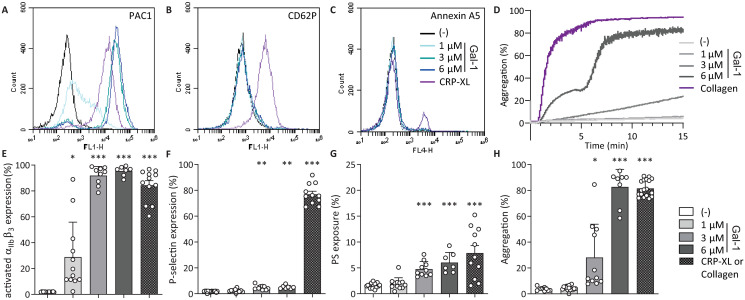
Galectin-1 induces different platelet responses.Flow cytometry measurements of platelets, assessing activation of integrin αIIbβ3 and P-selectin using fluorescently labelled PAC-1 (A, E), anti-CD62-P (B, F), and annexin A5 (C, G), respectively. Representative histograms represent washed platelets incubated with different concentrations of gal-1 (A-C) or 1 μg/mL CRP-XL for 15 minutes and bar graphs represent the percentage of platelet αIIbβ3 activation (E), P-selectin expression (F) and PS-exposure (G) by gal-1. Light transmission aggregometry of washed platelets (D) and quantification (H), incubated with different concentrations of gal-1 or 5 μg/mL collagen for 15 minutes. Bars represent mean ± SD (n = 3-5 measured in duplo). *p < 0.05, **p < 0.01, ***p < 0.001 as compared to control (Kruskal Wallis/Dunn’s test).